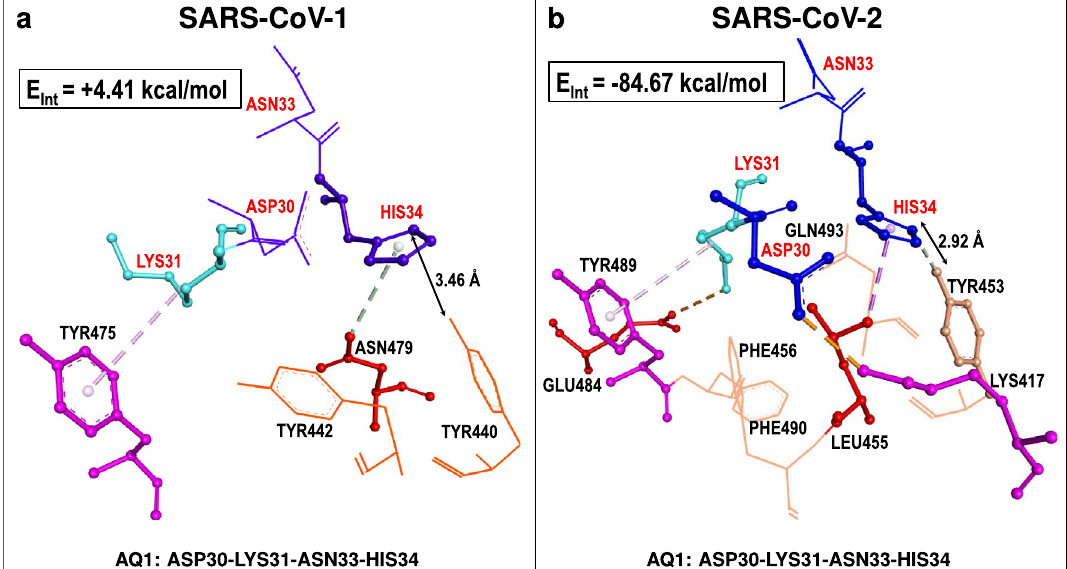
Figure 8. Comparison of hACE2-centered supermolecular fragment corresponding to hACE2...S-RDB interfaces of SARS-CoV-1 and SARS-CoV-2. Residues of hACE2 quartet AQ1 (red labels) and neighboring S-RBD residues (black labels) corresponding to ( a ) SARS-CoV-1 and ( b ) SARS-CoV-2 are shown. Selected intermolecular interactions corresponding to (i) carbon (non-classical) hydrogen bonds (dotted silver lines), (ii) π -sigma or π -alkyl interactions (dotted pink lines) and (iii) electrostatic interactions (dotted brown lines). Within the same 4.5 Å radius AQ1 interacts, via several attractive mechanisms, with more contact residues of SARS-CoV-2 than residues of SARS-CoV-1. Total interaction energies for each supermolecular fragment ( E are shown 7 (Table